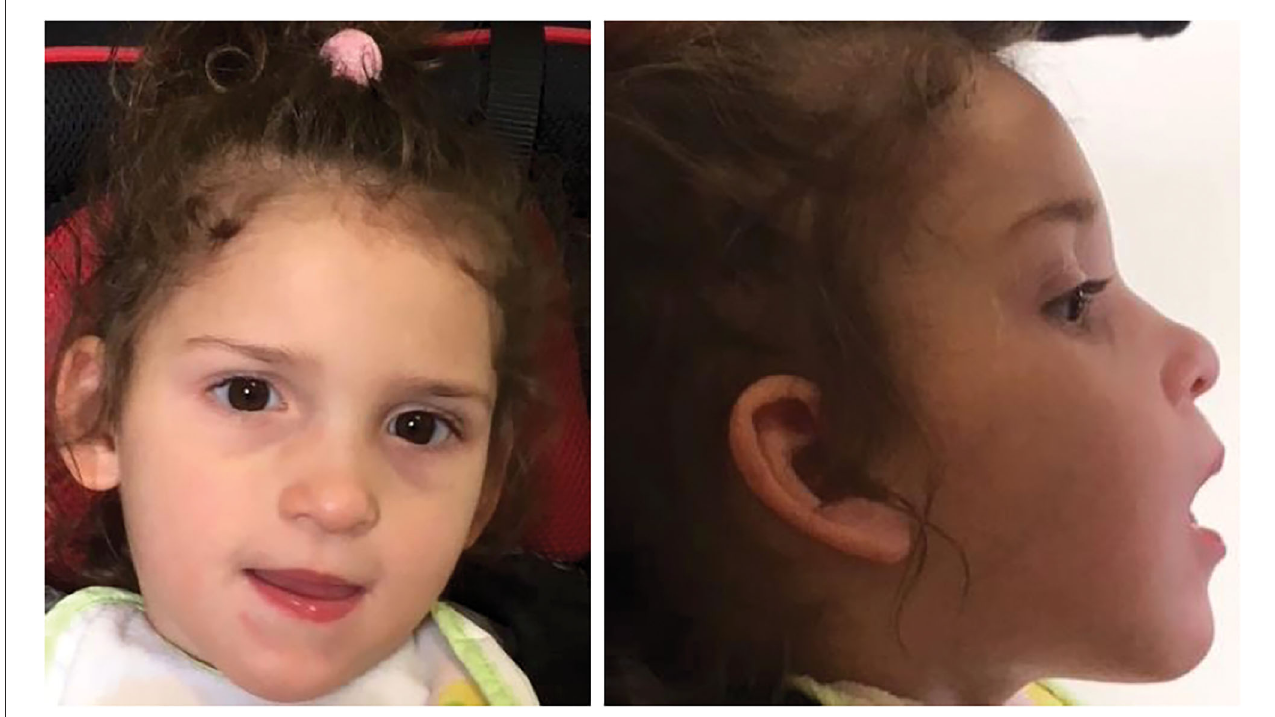
FIGURE1 Cranio-facial phenotype of the case including up-slanting palpebral fissures, epicanthal fold, depressed nasal bridge anteverted nares, long philtrum, low-set and posteriorly rotated